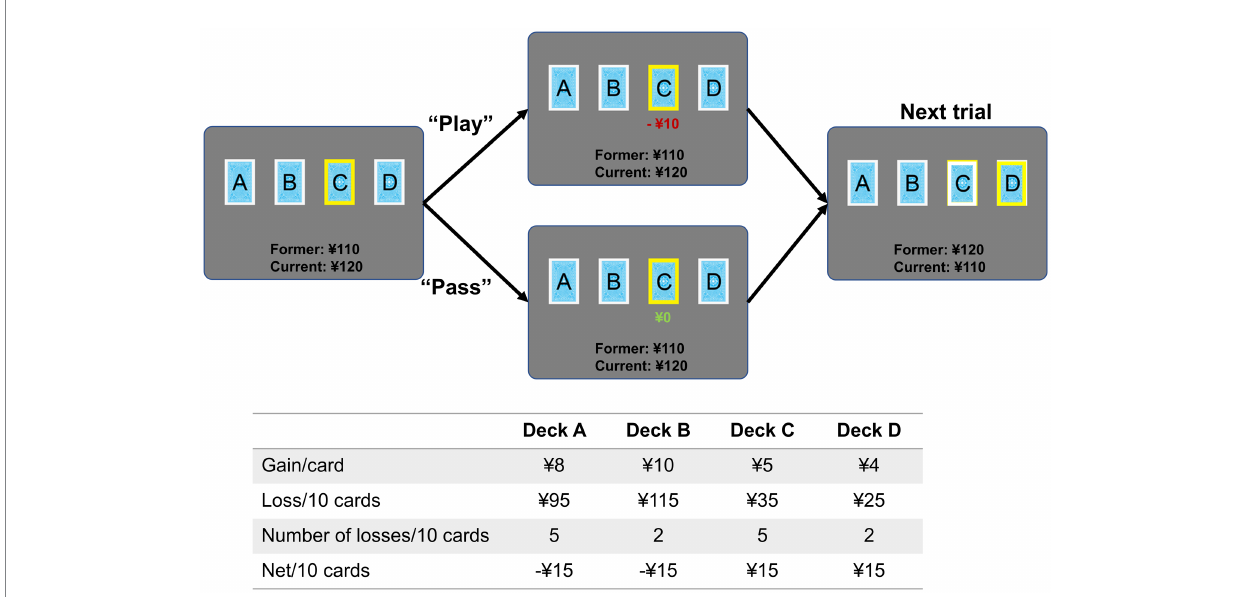
FIGURE 1 Task paradigm of the Iowa Gambling Task. Each trial began with a yellow frame displayed on one of the four decks randomly. Participants were required to make a response by pressing buttons in the left (“play”) or right (“pass”) hand as soon as possible within 4 s. The jittered inter-trial interval was 2–4 s. The table shows the probability of gain/loss for each deck, and earnings in 10 trials. Cards from decks A and B resulted in higher rewards than cards from decks C and D, but they also resulted in higher